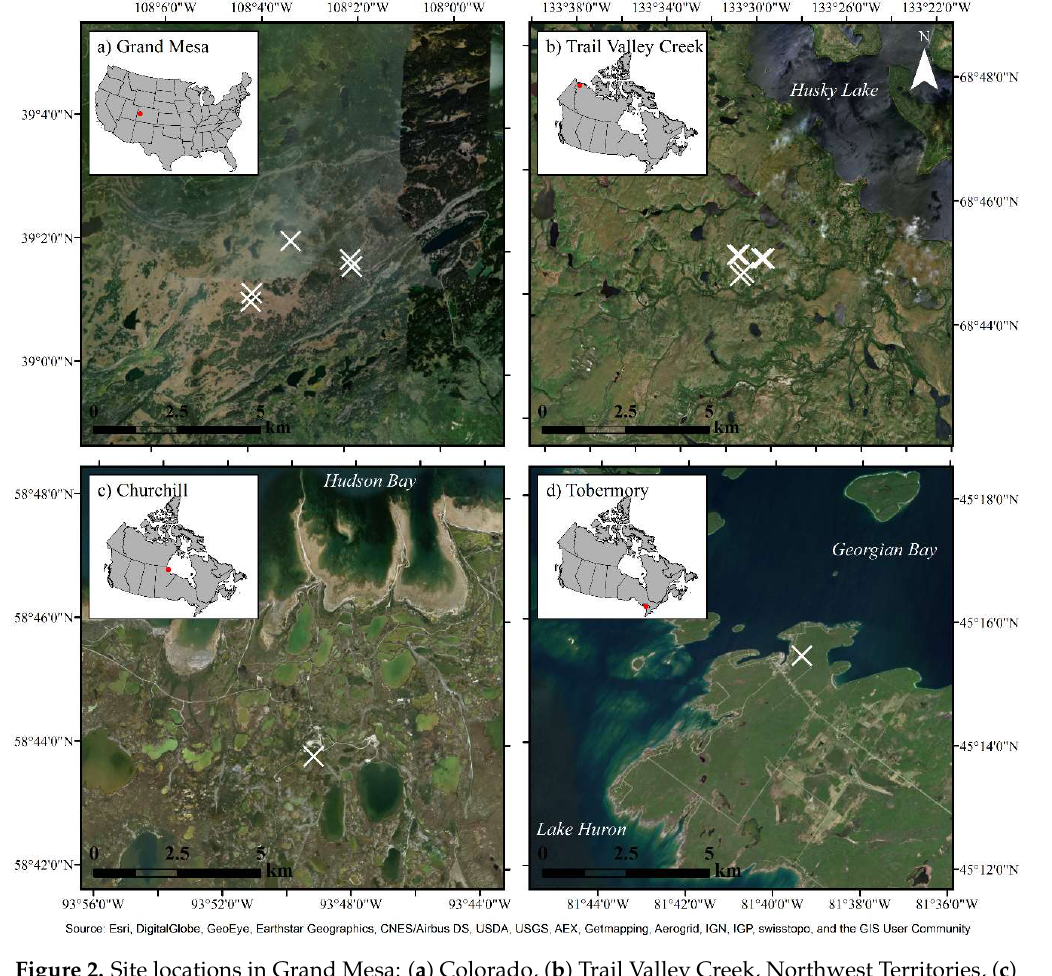
Figure 2. Site locations in Grand Mesa : ( a ) Colorado, ( b ) Trail Valley Creek, Northwest Territories, ( c ) Churchill, Manitoba, and ( d ) Tobermory, Ontario.